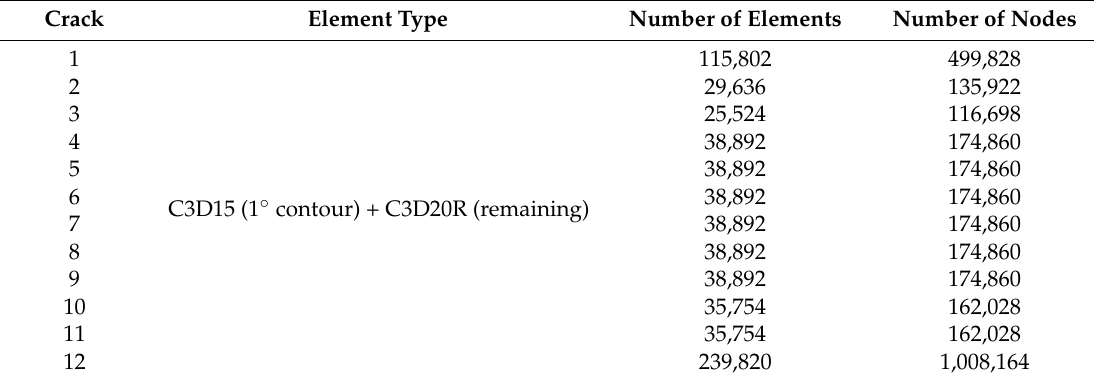
Table 3. Information regarding each numerical model that converged.